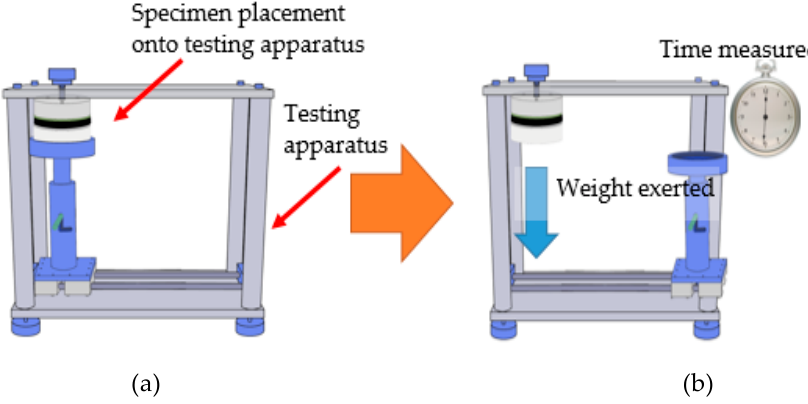
Figure 10. The test method apparatus: ( a ) the specimen installation onto the wet surface adhesion strength testing apparatus and ( b ) removing the bottom platform and initiating testing.